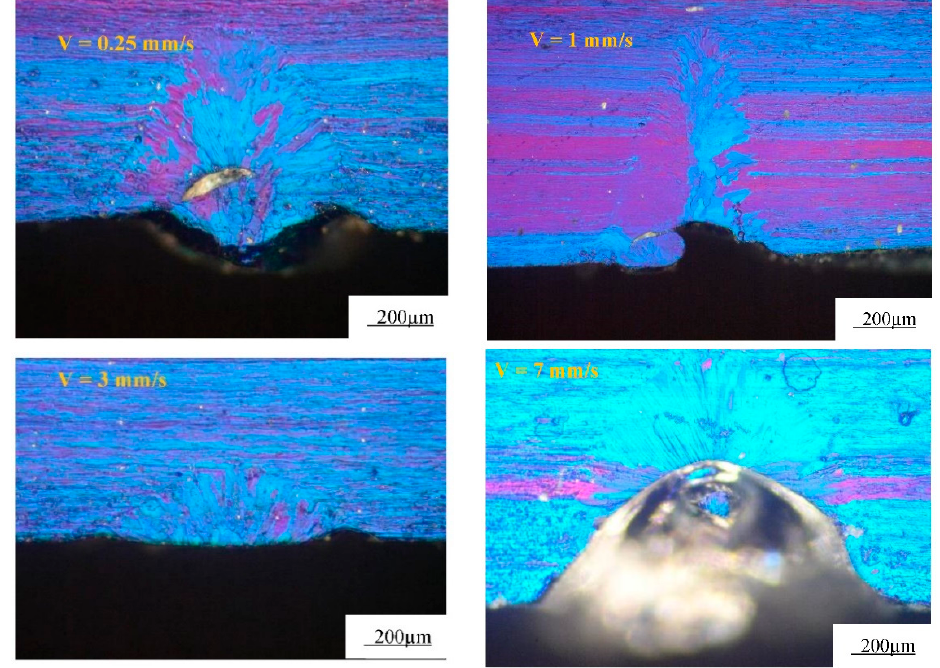
Figure 3. Influence of laser speed on the cross-section morphology of the weld seam. (P = 0.91 kW; Ar f = 15 mm − 1 ; Δ z = − 2 mm).